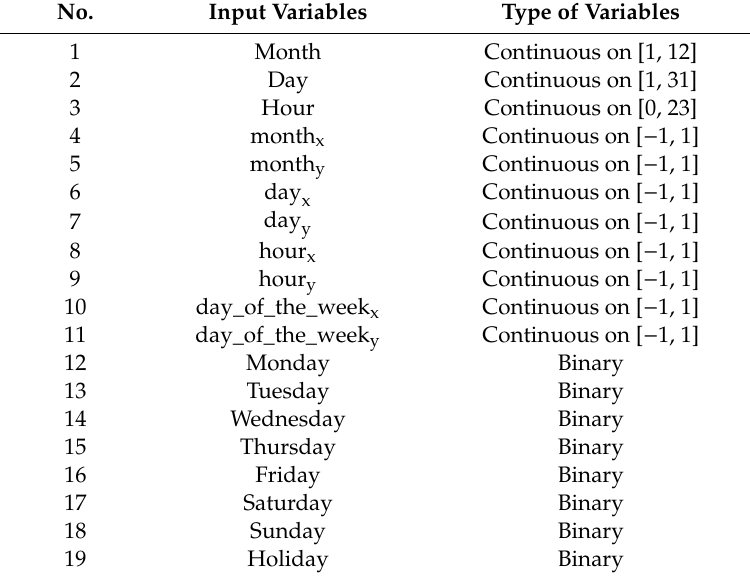
Table 3. Input variables of time